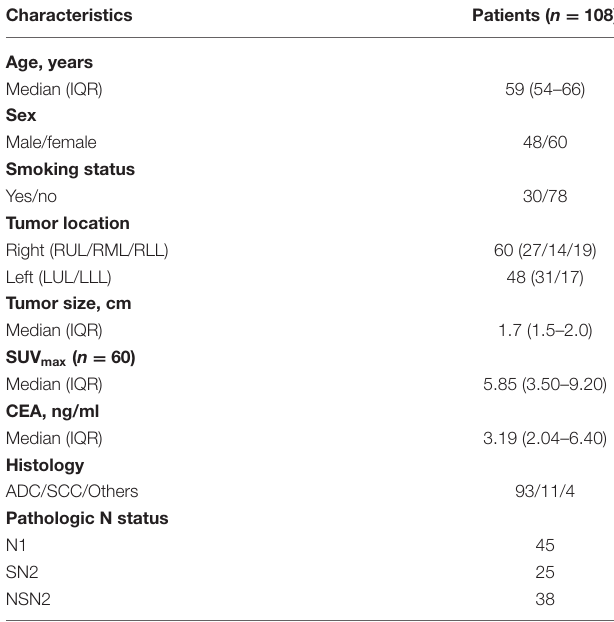
TABLE 2 | The characteristics of patients with non-small cell lung cancer ( ≤